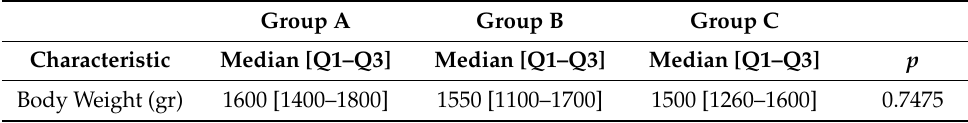
Table 1. Characteristics of the three groups. gr = gram.